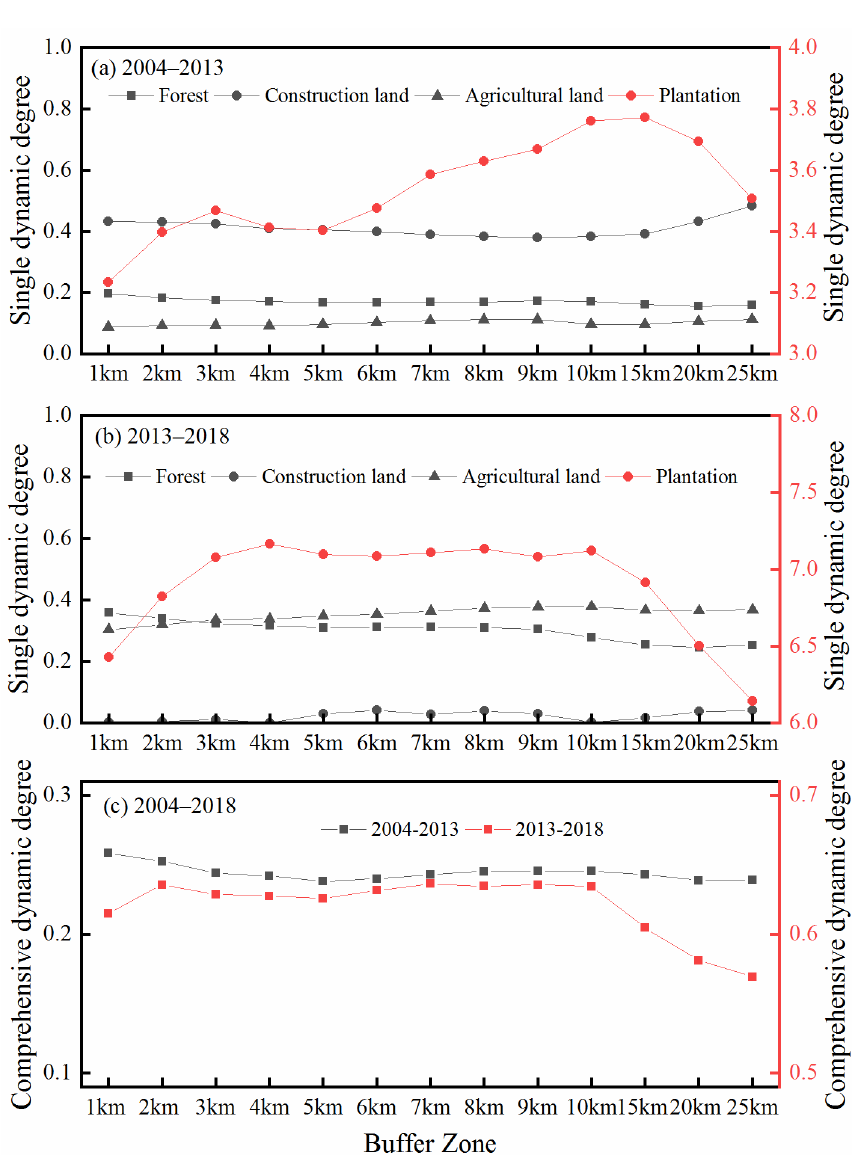
Figure 3. Single/comprehensive degree of land use dynamics in buffers of Kunming–Bangkok Highway. ( a ) Single land use dynamics from 2004 to 2013; ( b ) Single land use dynamics from 2013 to 2018; ( c ) Comprehensive land use dynamics from 2004 to 2018.